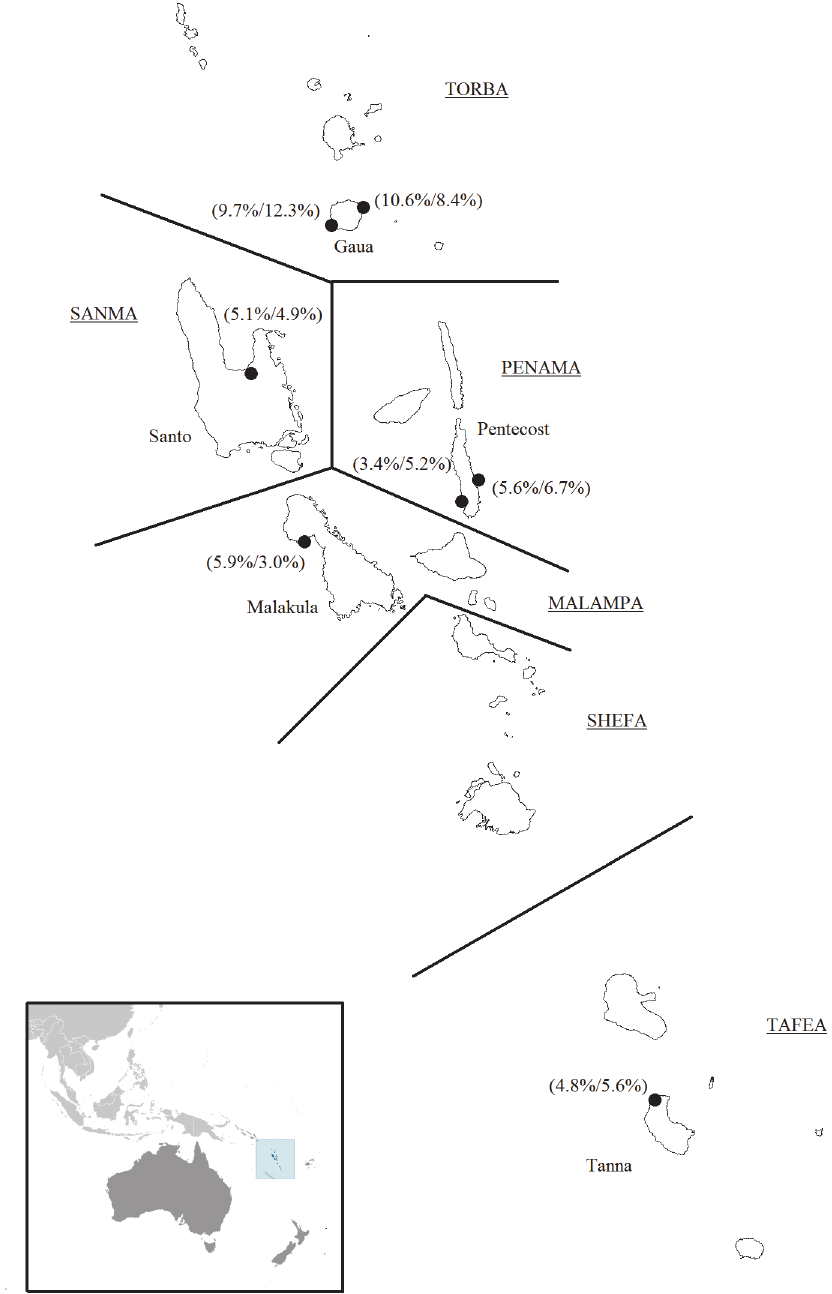
Fig 1. Map of Vanuatu showing the seven collection sites (black circles) on five islands. The names of the six provinces in Vanuatu are capitalized and underlined, and approximate provincial boundaries are indicated by solid lines. Species-specific parasite rates ( P . falciparum / P . vivax ) for each site were determined by microscopy. Maps were provided by the Library at the CIA (regional) and DIVA-GIS